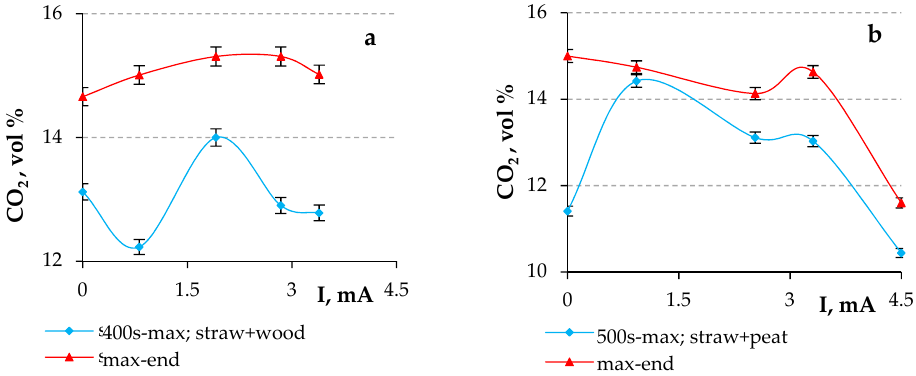
Figure 10. Electric field effect on the CO 2 volume fraction in flue gases when co-firing 30% straw with wood ( a ) or with peat ( b ) pellets.